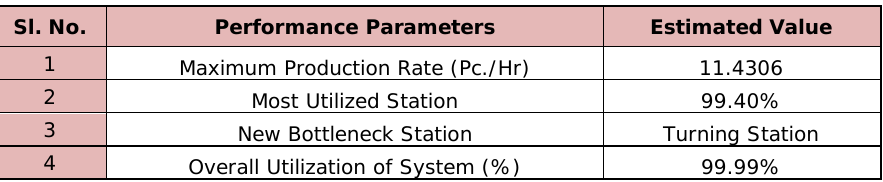
Table 7. “Performance Parameters of proposed FMS”. Source: Own